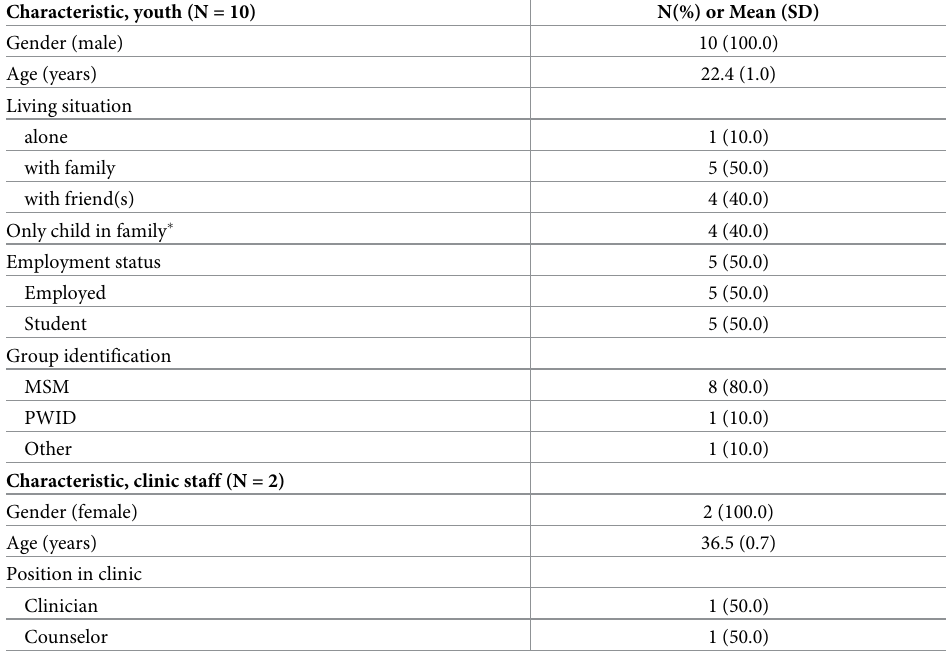
Table 1. Characteristics of interview participants. Characteristic, youth (N =